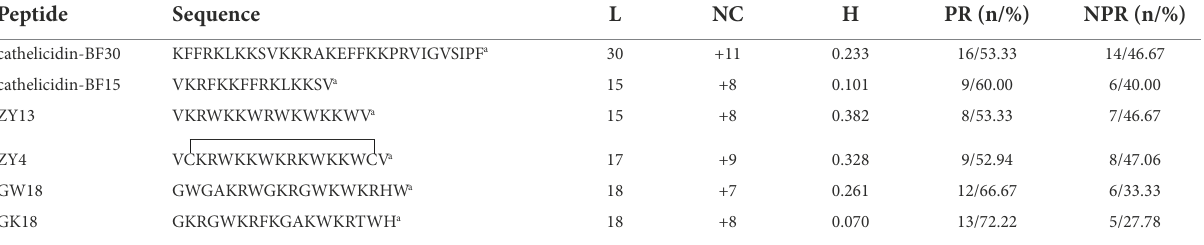
TABLE 1 Physicochemical properties of the designed peptides.